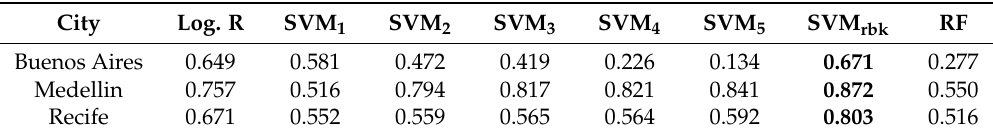
Table 4. Unified Model for Slum Detection ( F2 -scores).